Question: Sum up the contents of this chart in one sentence.
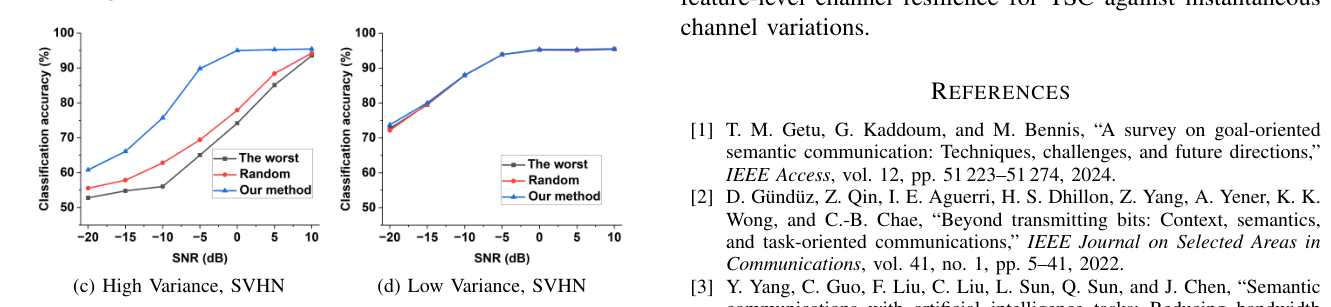
Answer: Comparison of inference performance between dynamic (high variation, 15) and stable (low variation, 2) subchannel environments on CIFAR-10 and SVHN tasks.